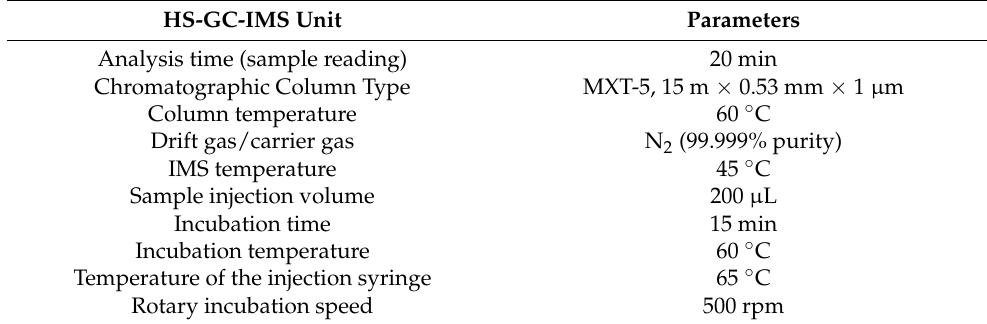
Table 2. Operating conditions of the HS-GC-IMS